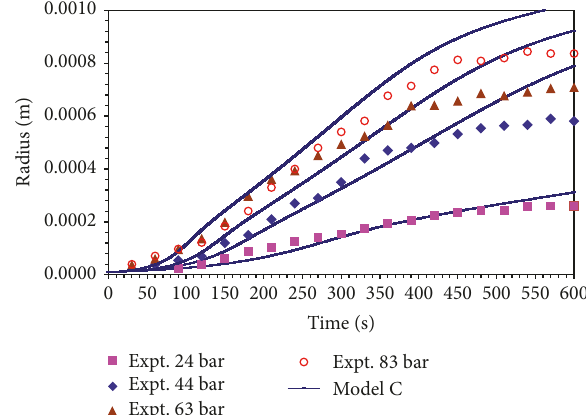
Figure 21: Model C versus experimental data for bubble growth at 100 ∘ C using WLF